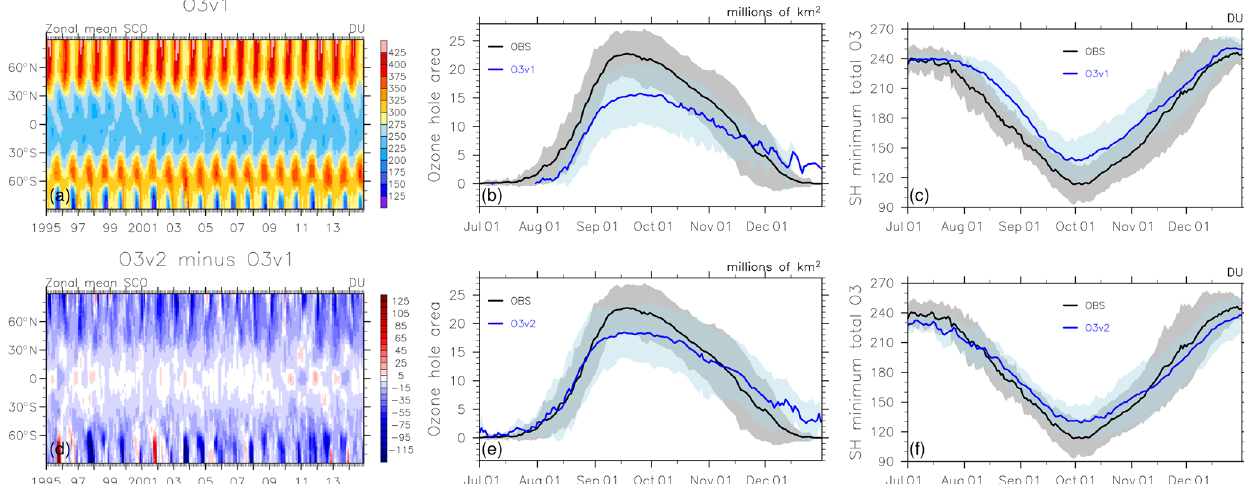
Figure 5. (a, d) Time series of zonal mean SCO by latitude (unit: DU) showing the Antarctic ozone hole over the years 1995–2014 and (b, e) daily evolution of the ozone hole from 1 July to 31 December as measured by area (10 6 km 2 ) and (c, f) minimum total column ozone (DU). Results are shown for the models E3SM O3v1 (a, b, c) and O3v2 (d, e, f) . Results for UCI CTM are not shown because daily diagnostics were not saved. Observations from the NASA ozone watch data for 1990–2019 are also shown in the two right columns. The lines indicate the multi-year mean (observations in black and models in blue), and shaded area covers ±